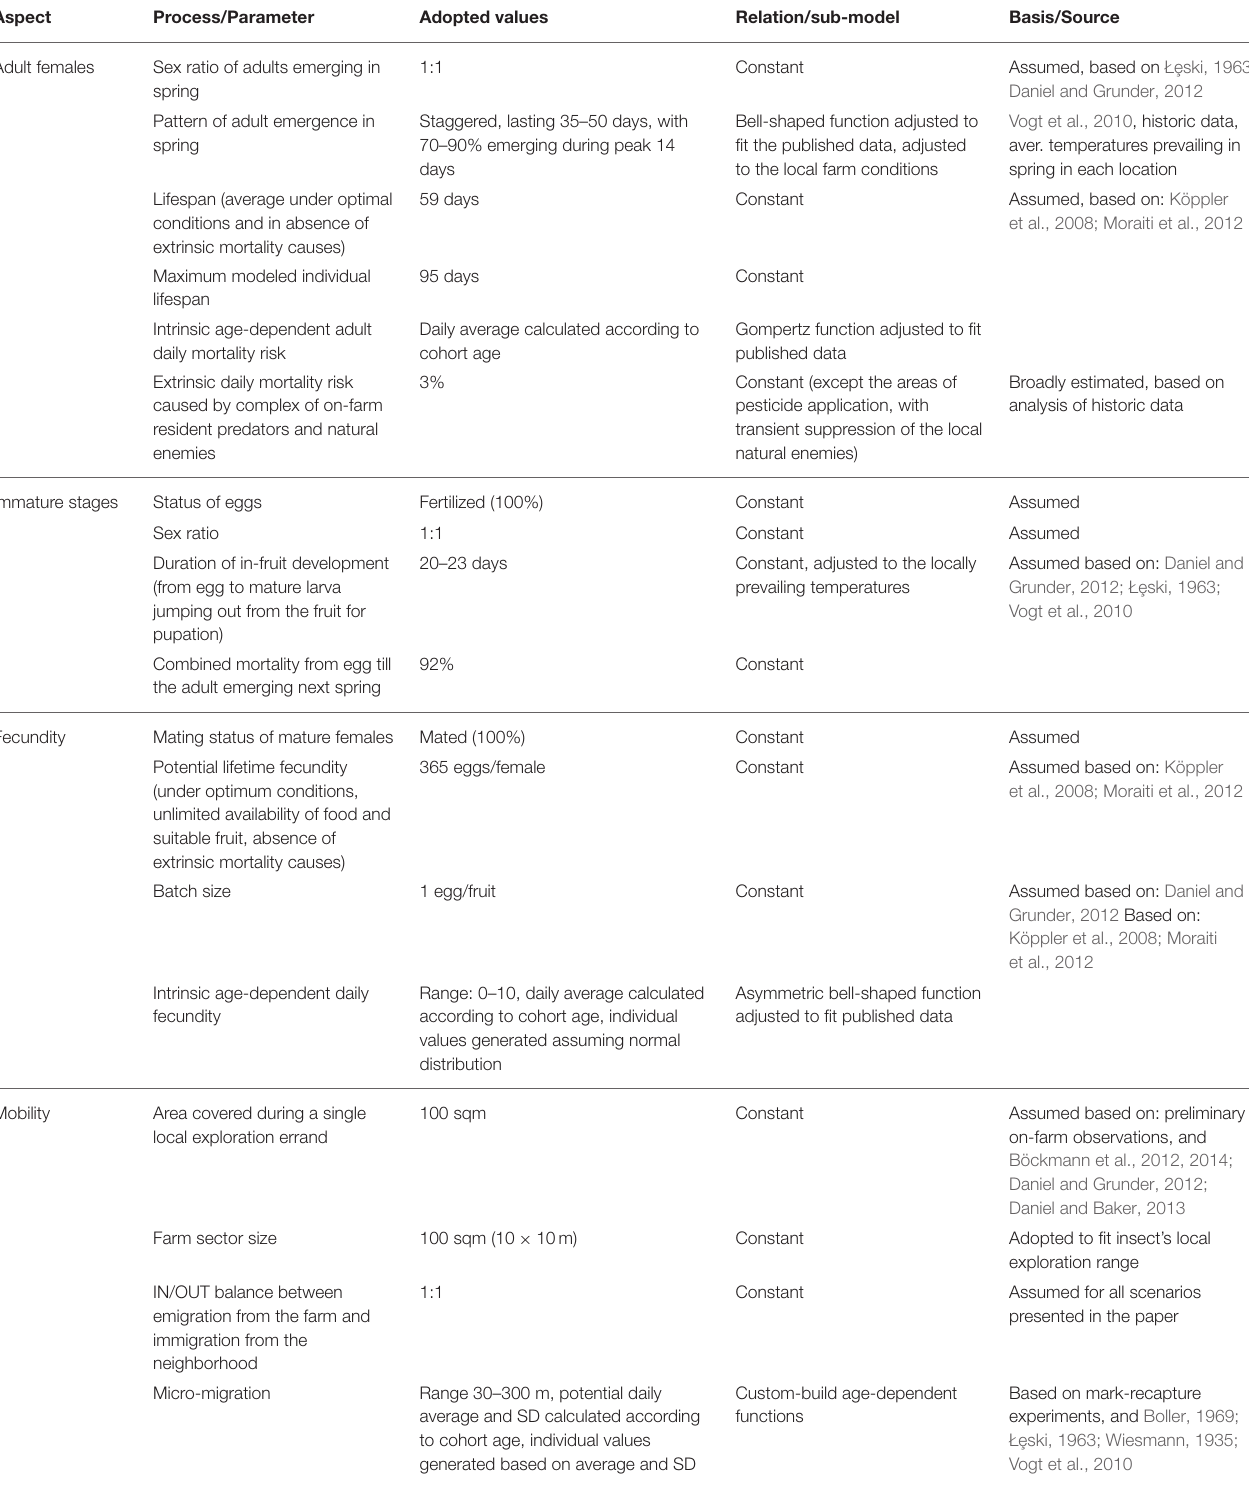
TABLE 1 | The main aspects of biology, key processes taken into account, and adopted parameters.